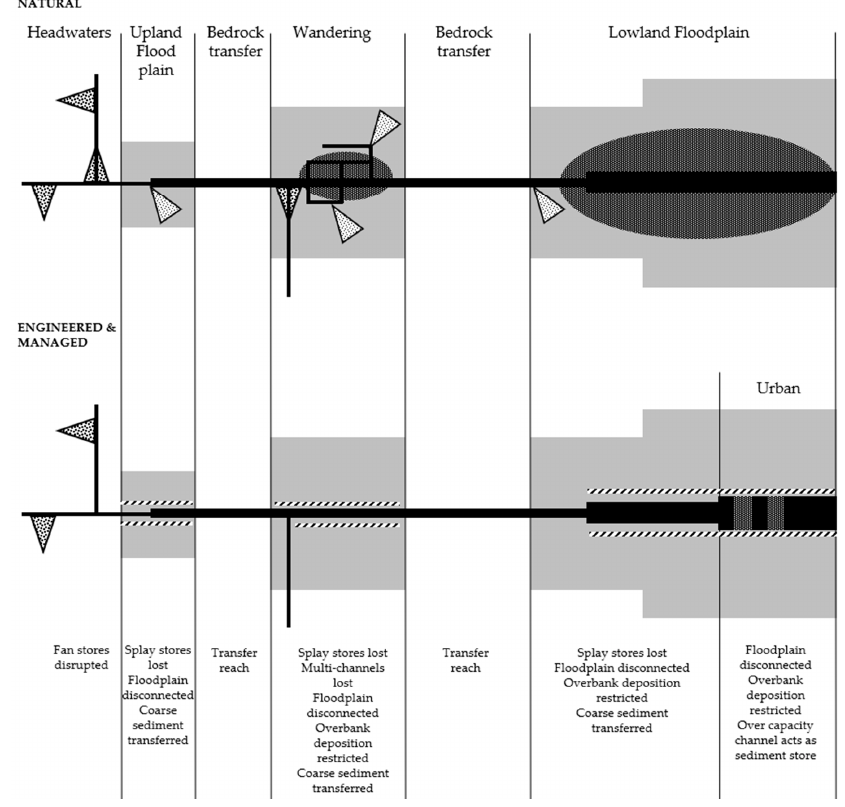
Figure 9. Summary impacts of lost coarse sediment storage due to engineering and management (black—channel, grey—valley bottom, dark grey-fans and splays, and dashed-barriers).